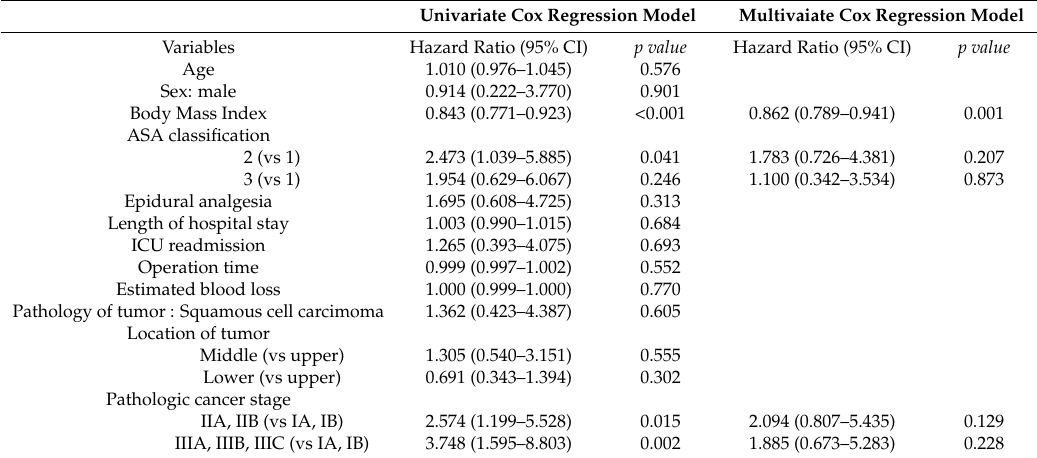
Table 3. Univariate and multivariate Cox regression analysis for recurrence-free survival in esophageal cancer